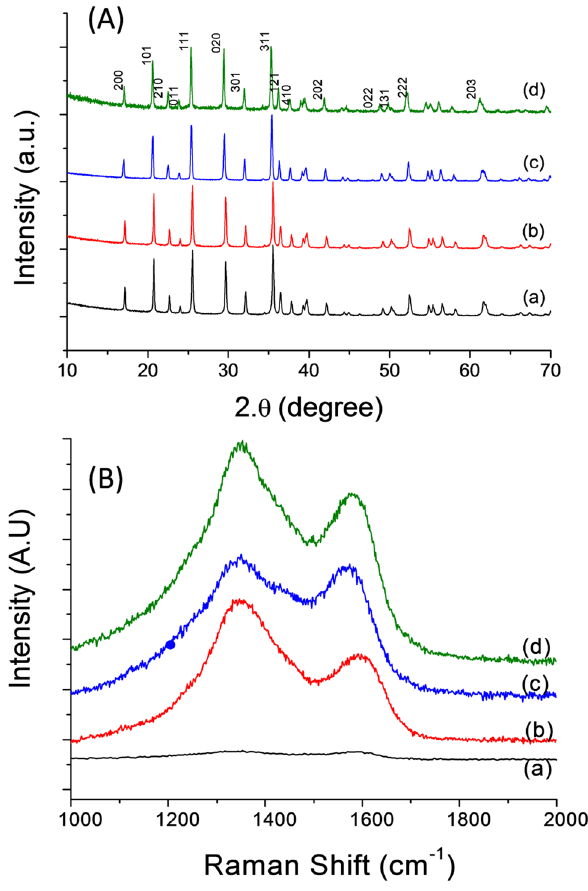
Figure 1. ( A ) X-ray diffraction patterns and ( B ) Raman spectra of olivine samples: (a) LiFePO 4 ; (b) LiMn